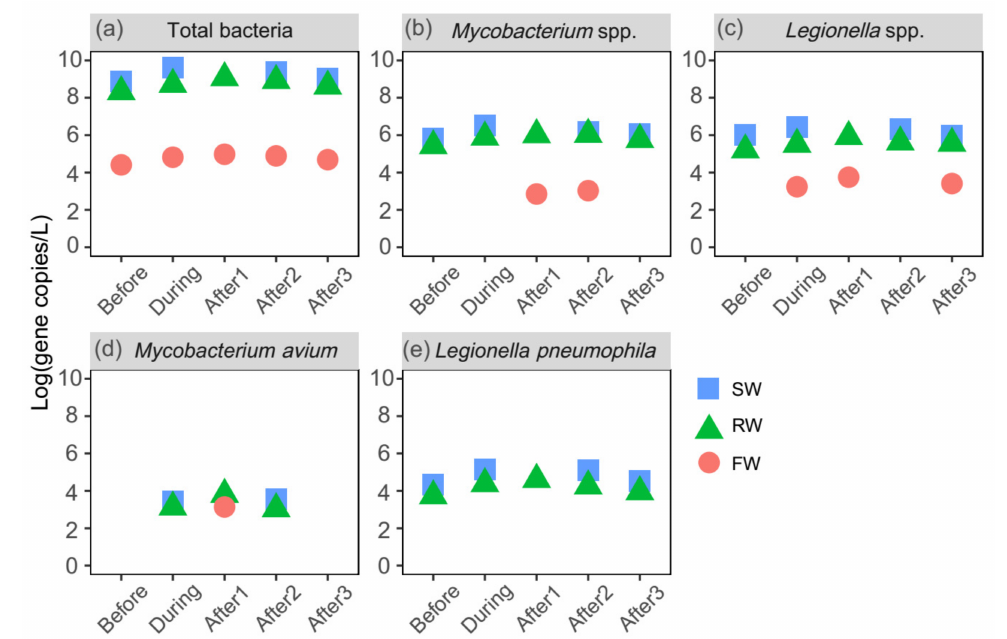
Figure 4. ( a ) Total bacteria and opportunistic pathogens, including ( b ) Mycobacterium spp., ( c ) Le- gionella spp., ( d ) Mycobacterium avium , and ( e ) Legionella pneumophila in source water (SW), raw water (RW) and finished water (FW) during the five-day super typhoon period (before, during and after one, two and three days of the typhoon event). The different colors and shapes represent different sampling sites. After1 SW sample is missing due to miscommunication during